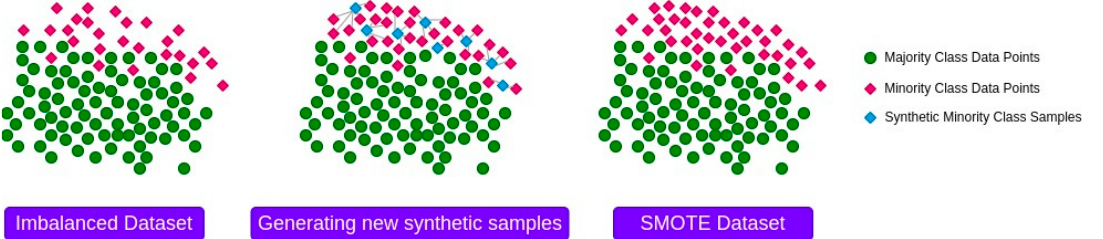
Figure 4. Illustration of SMOTE Oversampling for Imbalanced Classification. By interpolating be-